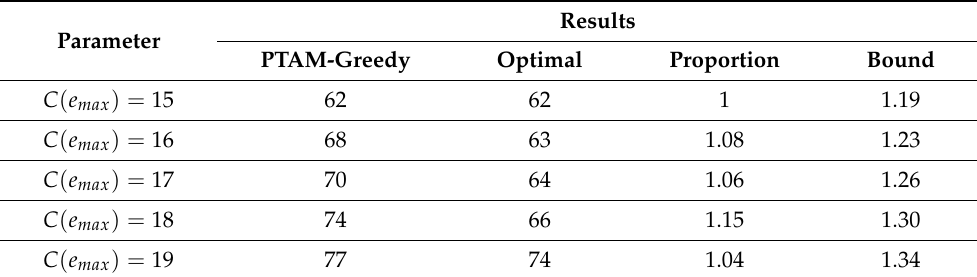
Table 2. Results under the condition that 3 users, 5 tasks, C min = 10. Results Parameter PTAM-Greedy Optimal